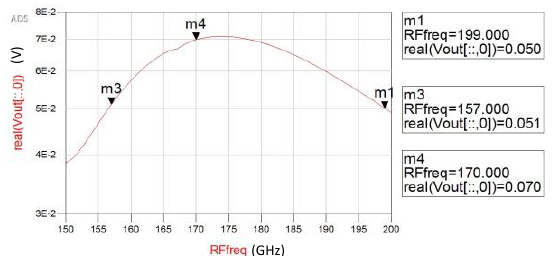
Figure 11 : The harmonic balance simulation results at -10